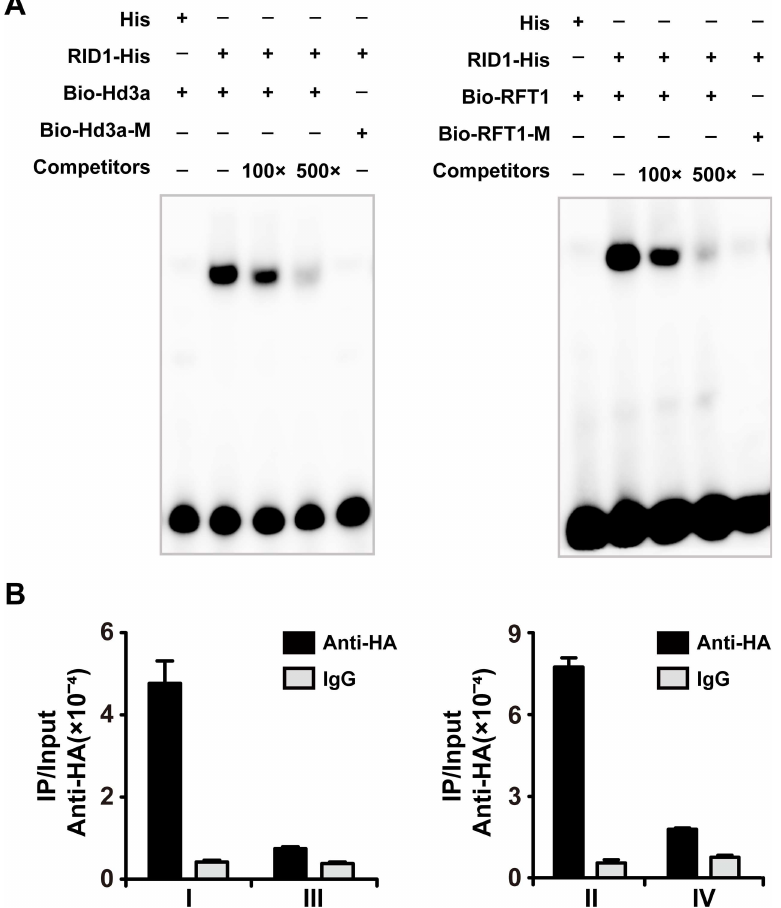
Fig 8. RID1 directly bind to the promoter regions of Hd3a and RFT1 . (A) Gel shift assays of His and His- RID1 recombinantproteins interactingwith promoterregion of Hd3a and RFT1 . Escherichia coli –produced recombinant RID1 protein were incubatedwith biotin-labeled Hd3a and RFT1 in the absenceor presenceof 100- or 500-foldmolar excess of the unlabeledprobesas competitor for the electrophoretic mobility shift assay (EMSA) reactionand analyzedby electrophoresis. The fragment with mutated core cis-element served as the negative control. (B) ChIP analysisof transgenic plants expressingRID1-FLAG-HA fusion protein. Nuclei from RID1-FLAG-HA transgenic plants’ leaves were immune precipitatedby anti-HA. The precipitated chromatinfragments were analyzedby qPCR using four primer sets amplifying Hd3a and RFT1 regions(I, II, III, and IV), as indicatedin Fig 7A. The input (without antibody precipitation)chromatinwas analyzedand used as the control. The ChIP experiments were repeatedtwo times using independent biologicalreplicateswith similar results, and one representative data set is